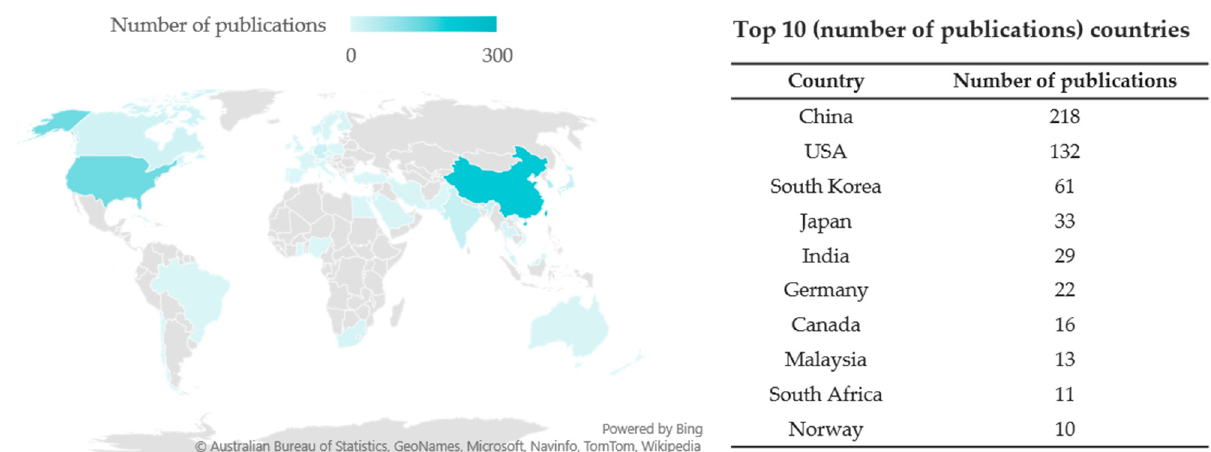
Figure 3. Geographical coverage of papers reporting the activity of natural products on CYP450s, and the top 10 countries ranked by the number of papers.